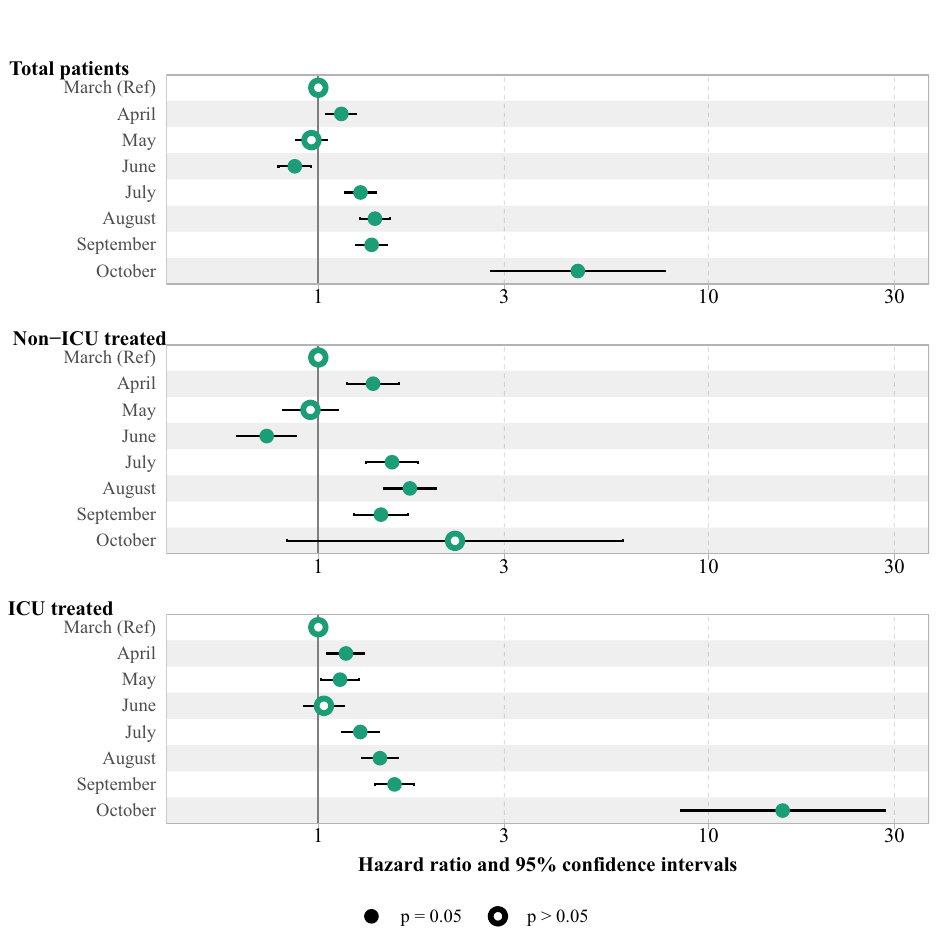
Figure 3. The trend of unadjusted death proportion due to COVID-19 among hospitalized patients per month. Error bars are the 95% confidence interval for death proportions.